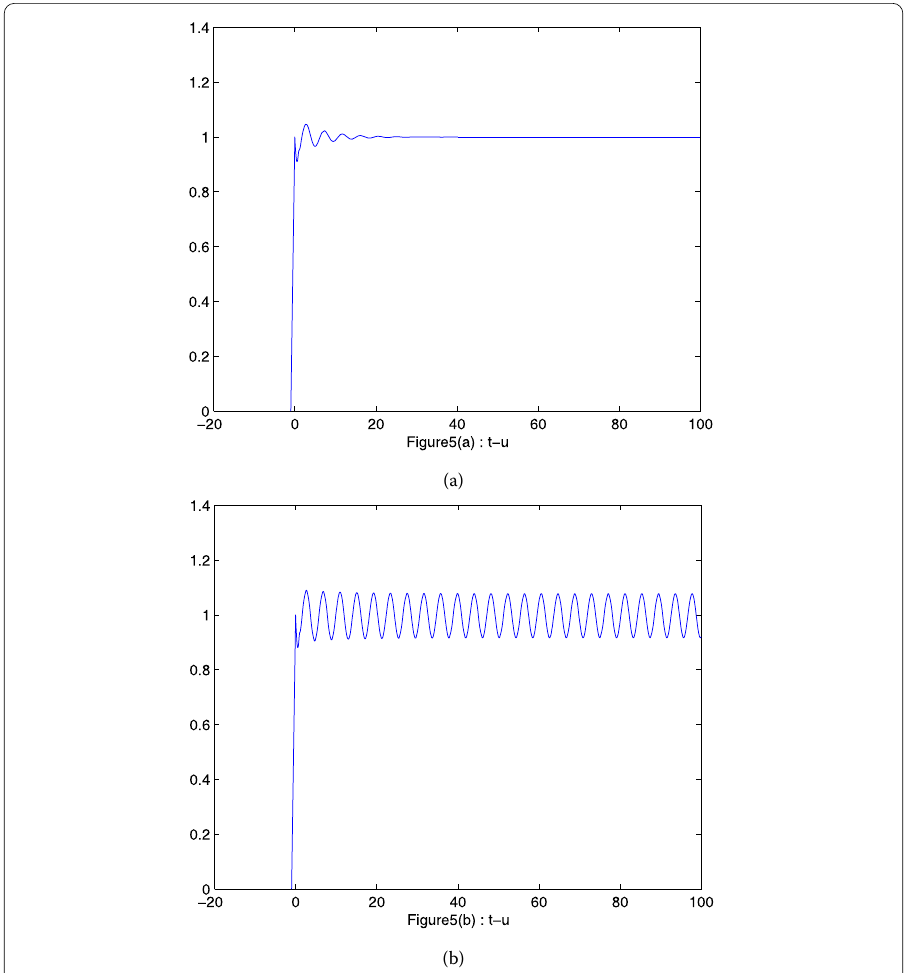
Figure 5 The numerical solution of Eq. (2.11) with PD control Euler method corresponding to k p = 0.09, k d = 0.8 when ( a ) τ = 0.6, ( b ) τ = 0.8